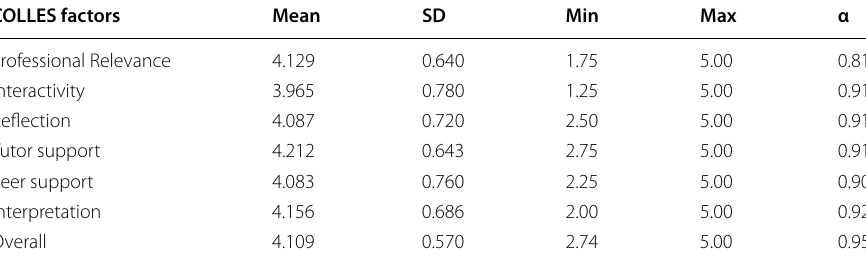
Table 3 Descriptive statistics and reliability for COLLES factors COLLES